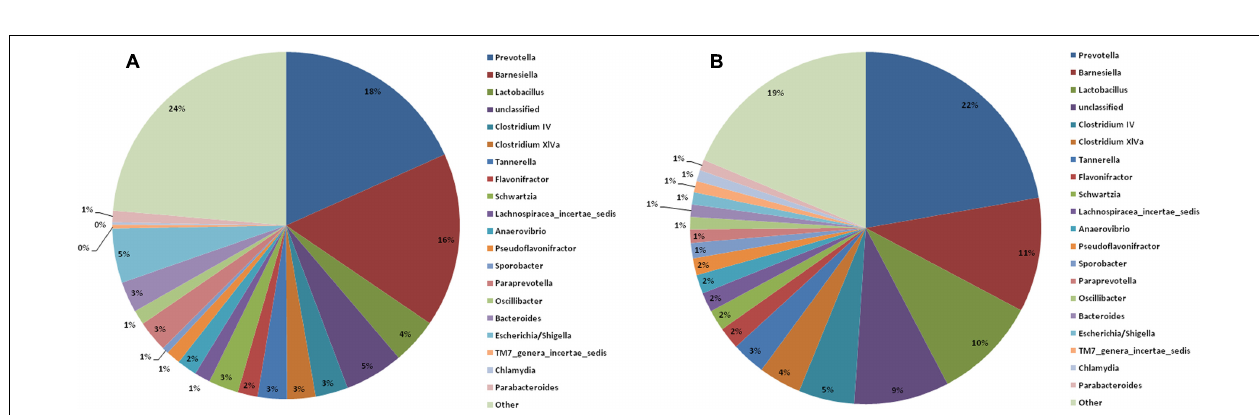
FIGURE 6 | Constituents of the gastrointestinal microbiome before (B) and after (A) burn injury at the genus level. Each genus is indicated by different colors or by other means (light green) for all other genera not in the top-20 list.